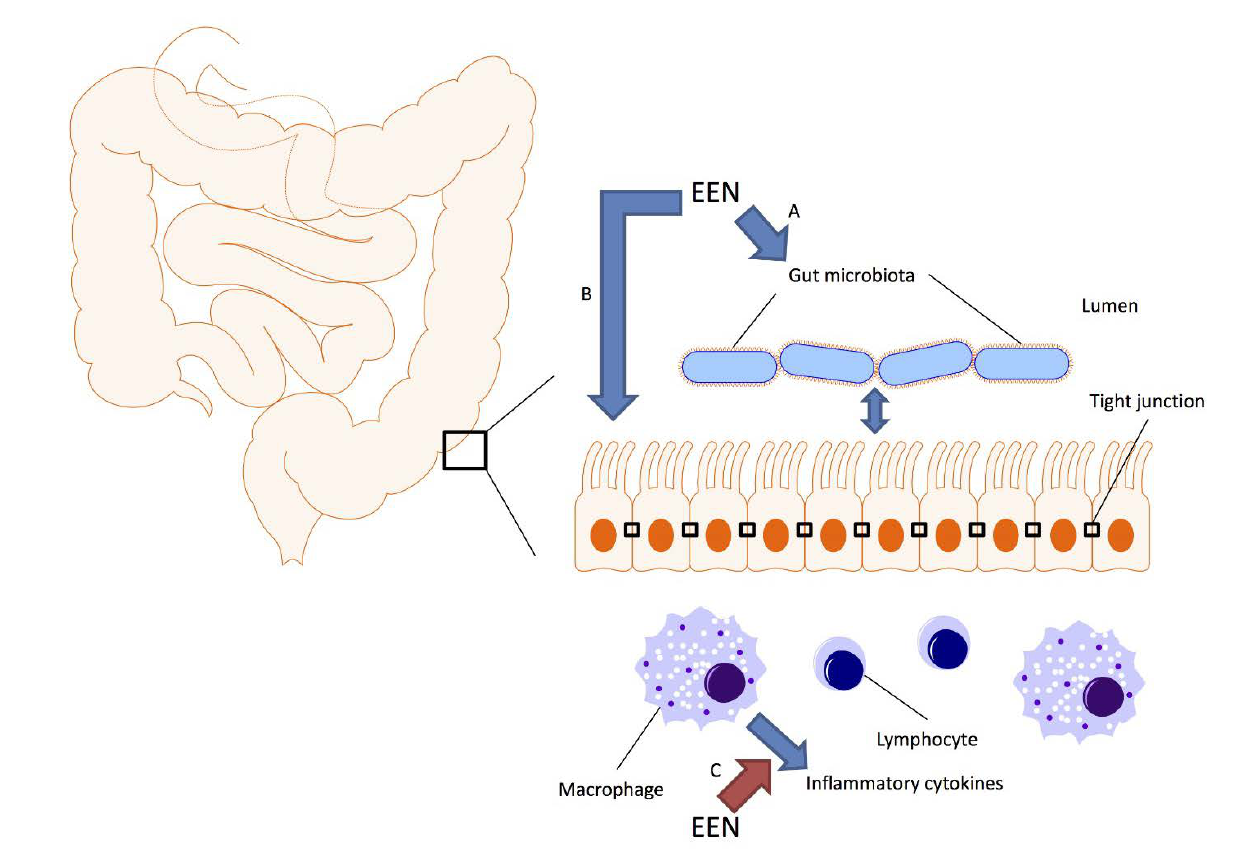
Figure 1. Schematic representation of the gut microbiota, the intestinal epithelium and immune system; and how exclusive enteral nutrition (EEN) may affect these systems. Crohn’s disease is associated with dysbiosis of the gut microbiota, increased permeability of the intestinal epithelium and dysregulated immunity. Studies suggest that EEN can alter the composition of the gut microbiota (A), reduce intestinal permeability through modulation of tight junctions either directly (B) or through modulating the intestinal microbiome (A) and downregulate the production of inflammatory cytokines either directly (C) or through modulating the intestinal microbiome